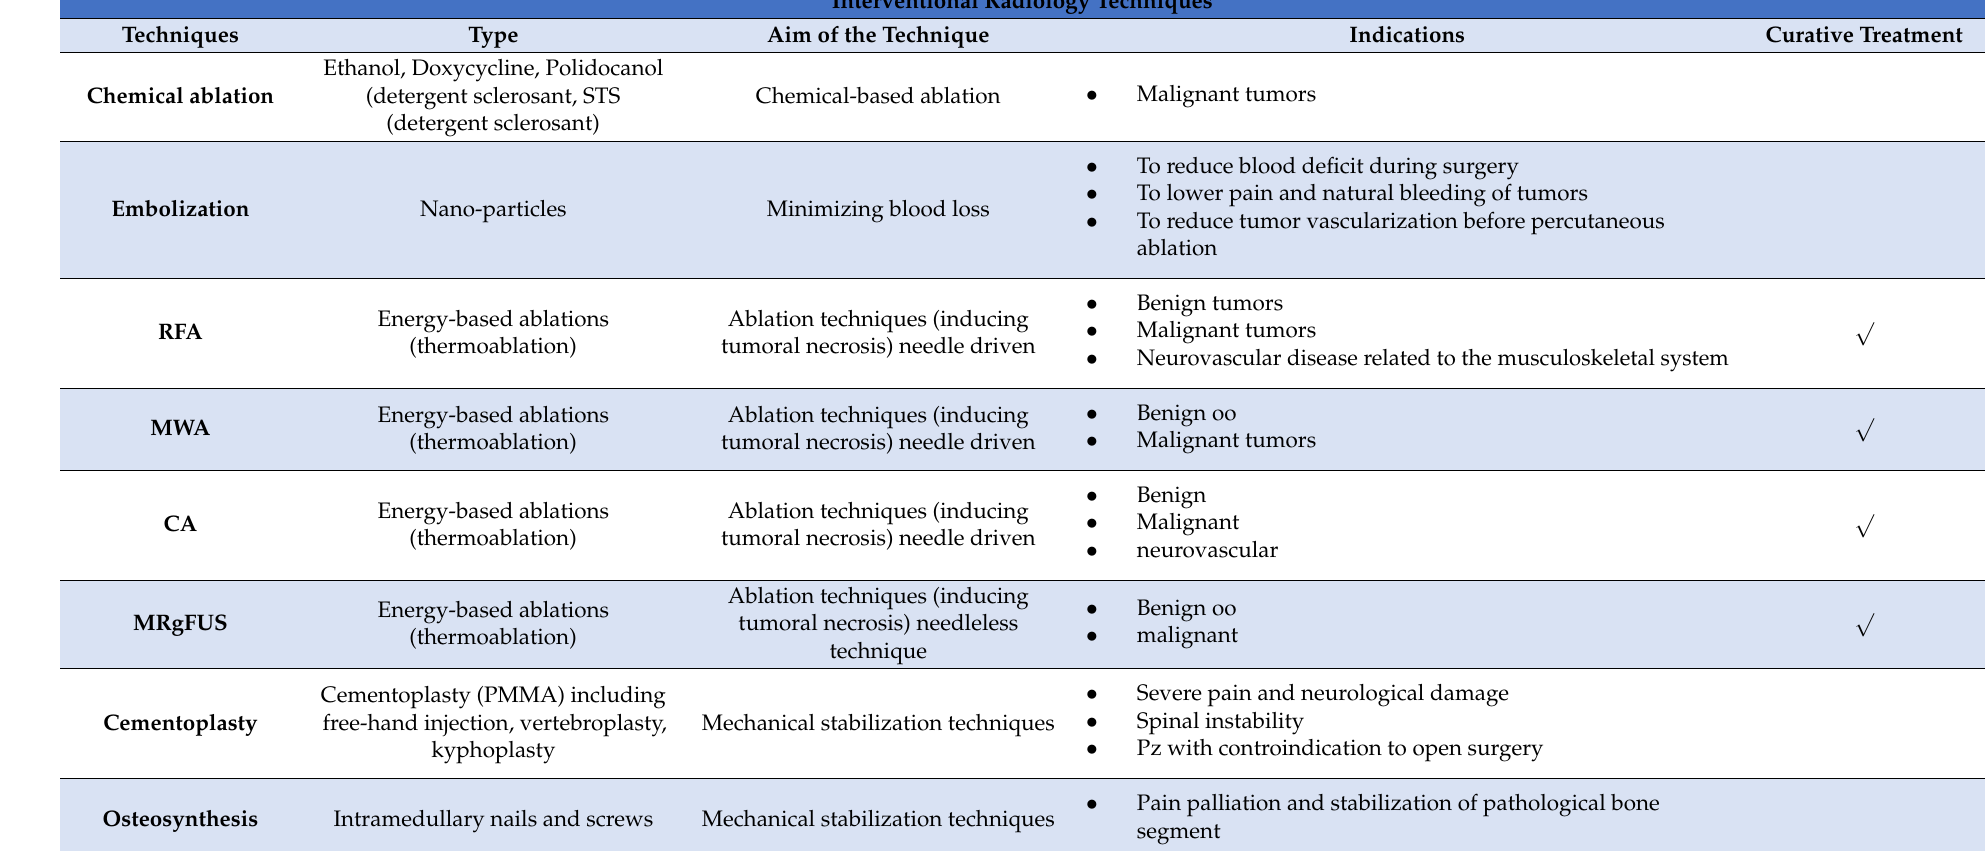
Table 1. Techniques of IR and their